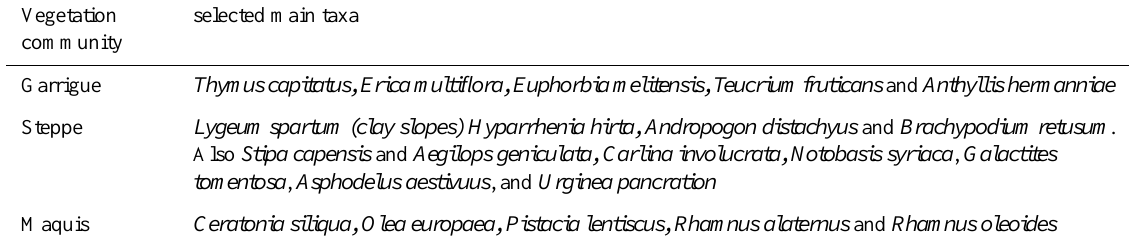
Table 1. Selection of plant taxa characteristic of the main Maltese vegetation communities (adapted from Schembri, 1997; Stevens et al.,